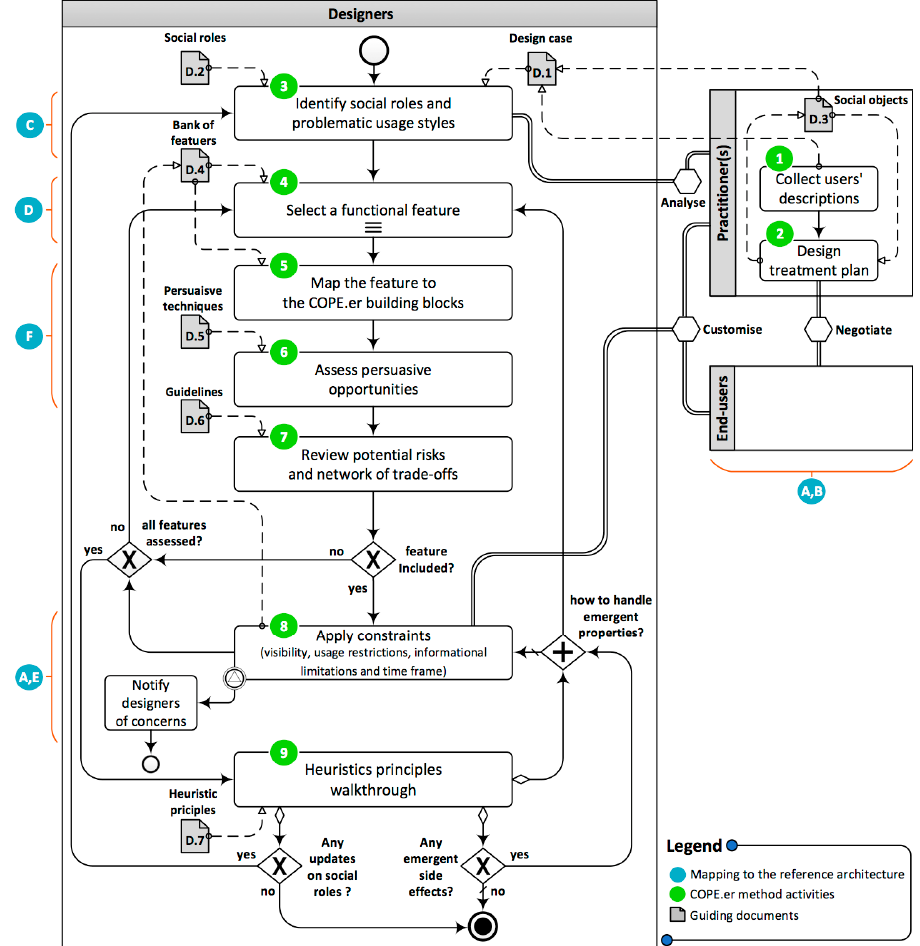
Figure 5. The COPE.er method workflow.